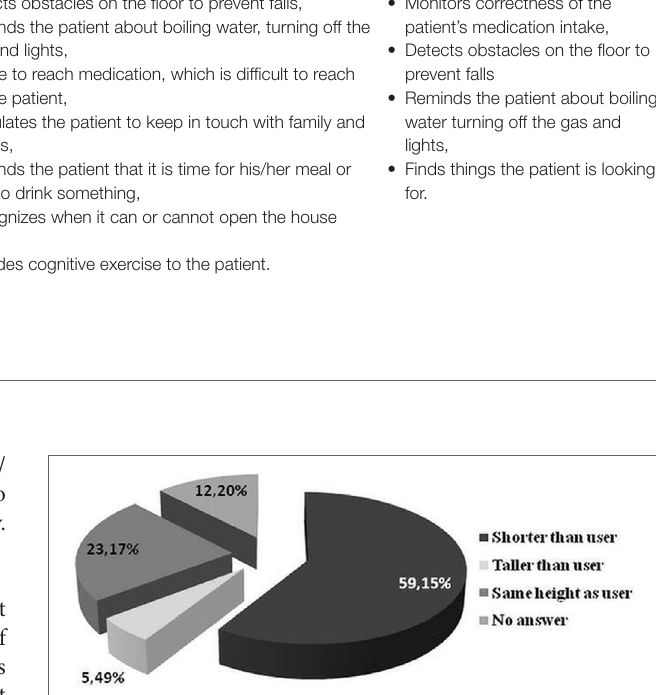
FigUre 1 | Percentage distribution of respondents’ preferences regarding the height of the robot .